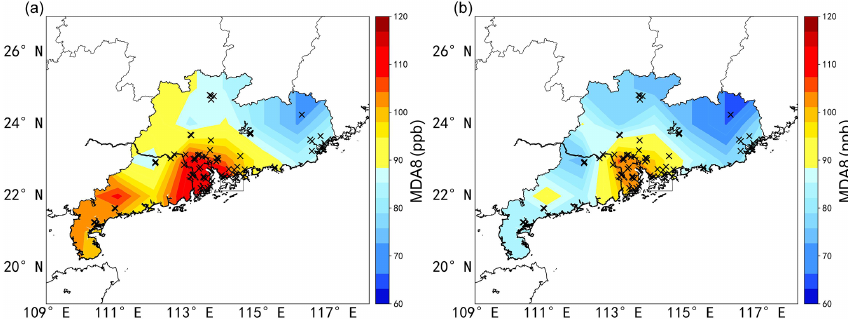
Figure 1. (a) Spatial distribution of the average maximum daily 8h average ozone concentration (MDA8) in Guangdong during the study period, black crosses mark the locations of observation sites. (b) Same as (a) but for MDA8 of all ozone exceeding days in Guangdong in 2018 and 2019.